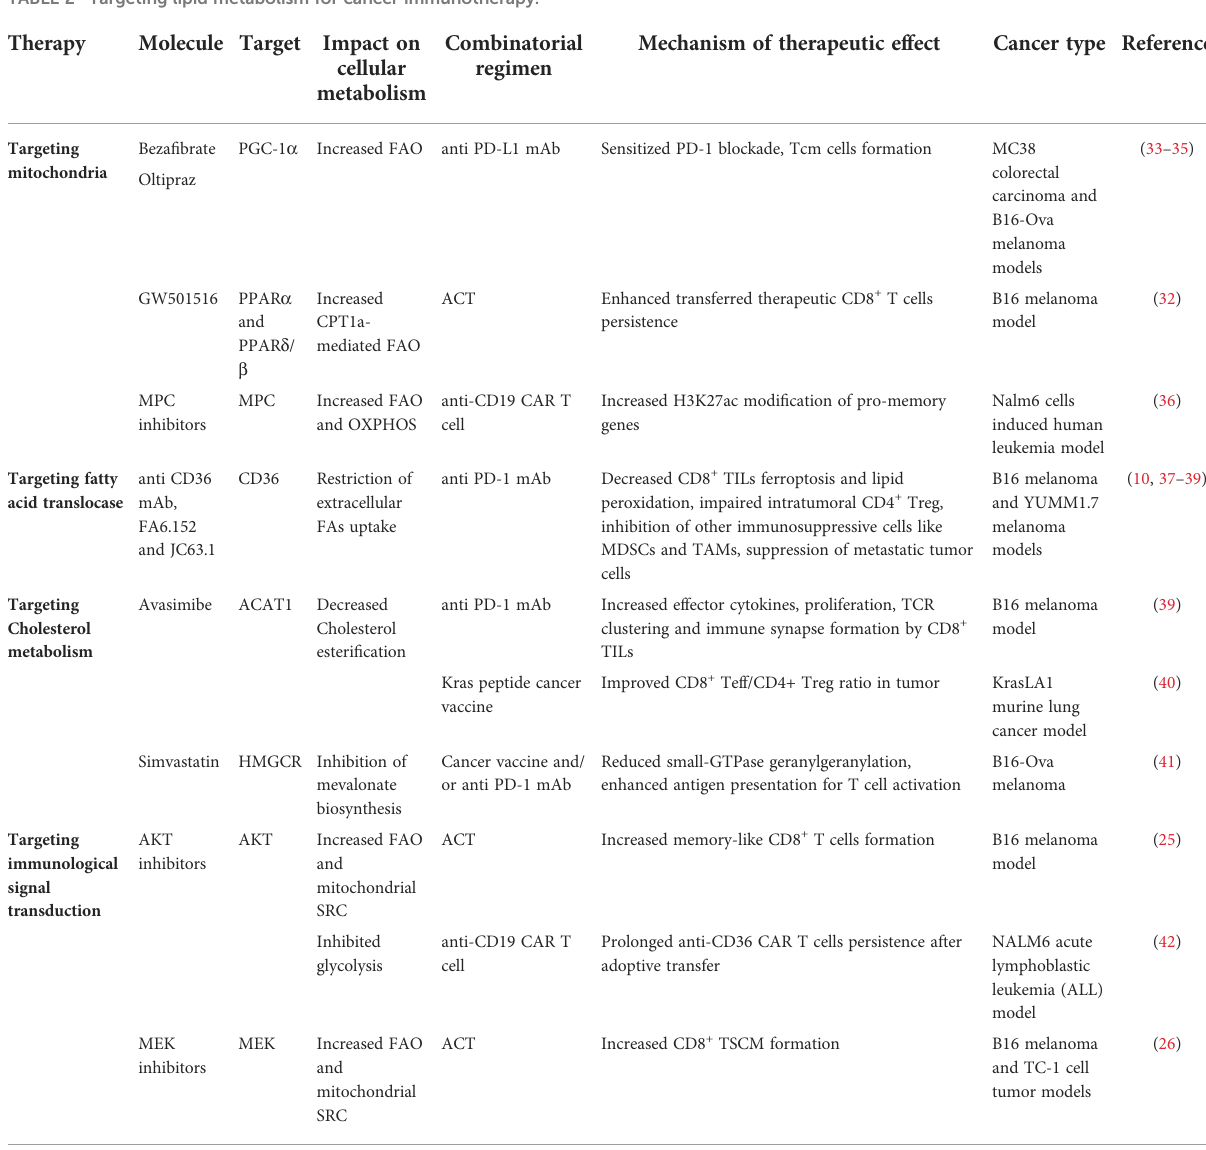
TABLE 2 Targeting lipid metabolism for cancer